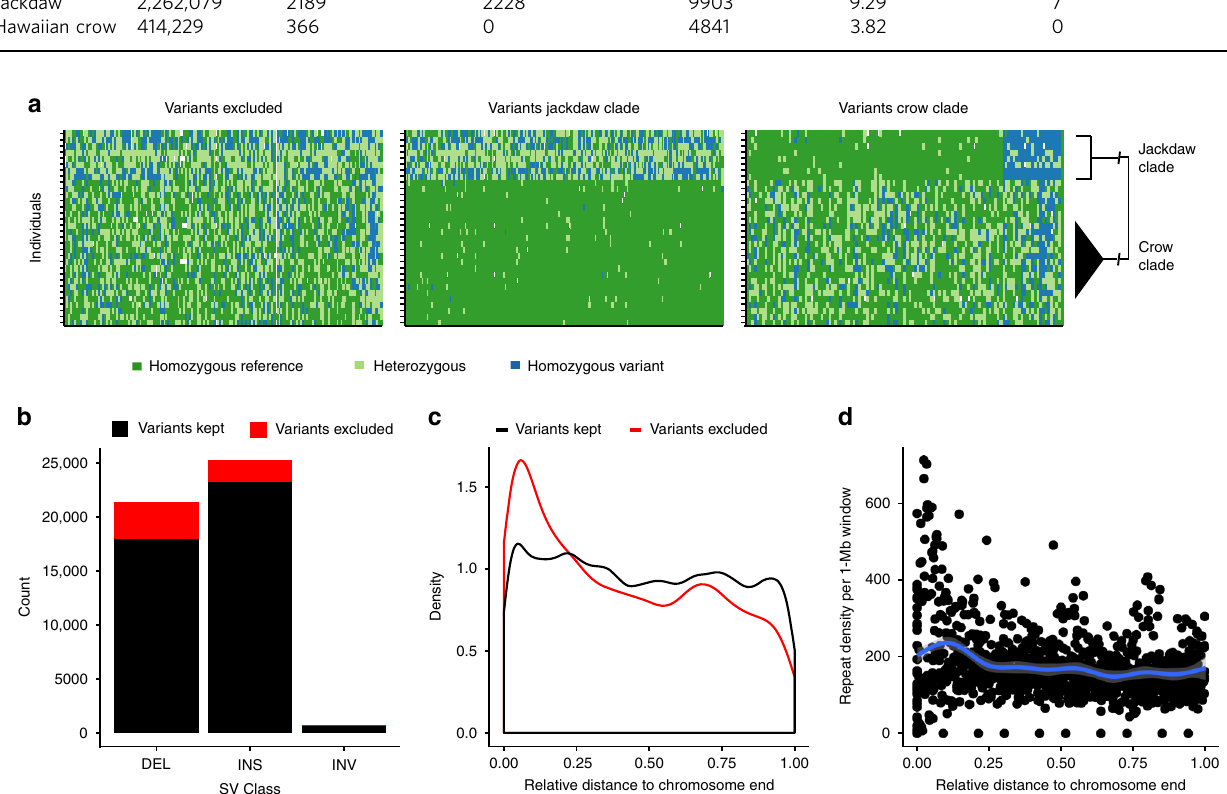
Fig. 2 Phylogenetic fi ltering of read mapping-based structural variants. a Example genotype plots of LR-based variants according to phylogenetically informed fi ltering. Given the large divergence time of 13 million years 18 between the crow and jackdaw lineage, the proportion of polymorphisms shared by descent is negligible 62 and therefore likely constitutes false positives or hypermutable sites (left). Variants segregating exclusively in the jacdaw or crow clade (middle and right), however, comply with the in fi nite sites model and were retained accordingly. Plotted are genotypes of one representative chromosome (chromosome 18), with genotypes of variants in different colors, where each row corresponds to one individual ( N = 8 individuals jackdaw clade and N = 24 individuals crow clade). Note that, due to the tolerance of a certain number of misgenotyped variants per clade, some variants are present in both clades. b Excluded versus retained variants in relation to SV class and chromosomal distribution. Excluded variants are enriched for deletions (LMM, p < 10 − 16 ) and c are most abundant at chromosome ends, coinciding with d , an increased repeat density. Source data are provided as Source Data fi